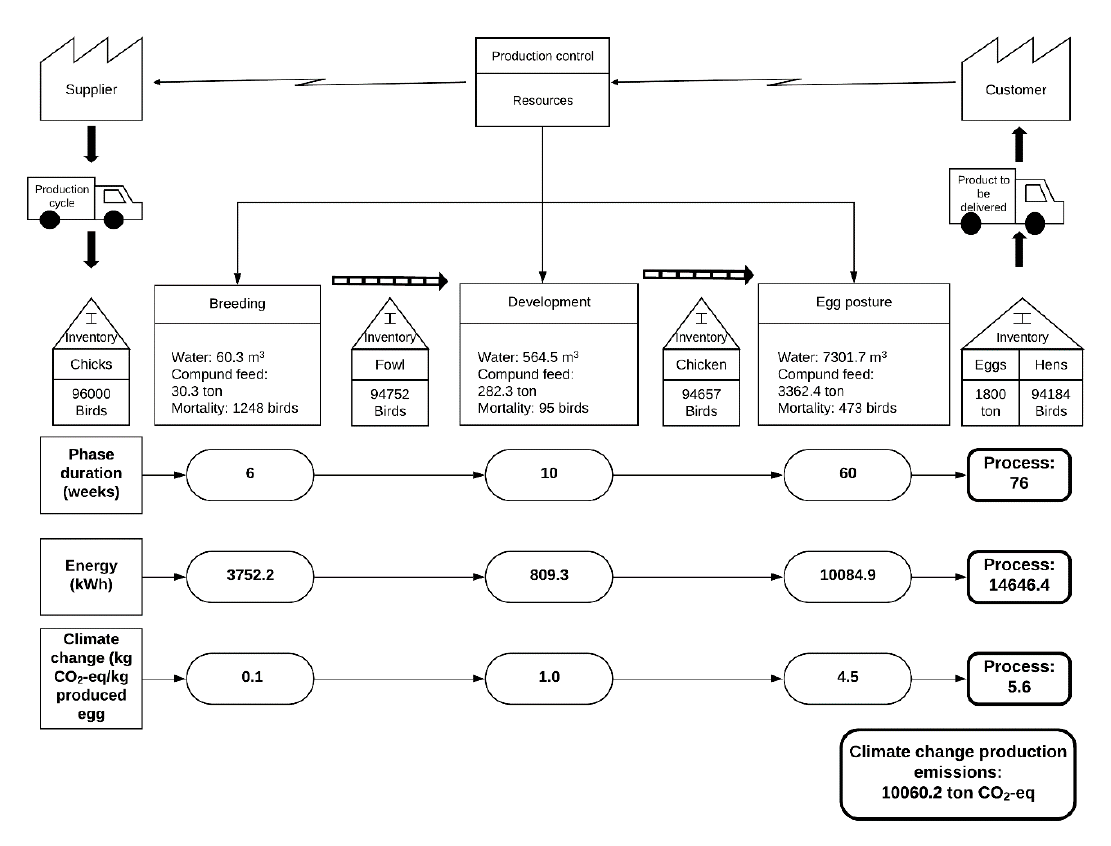
Figure 7. Climate change emissions from the current egg production process.